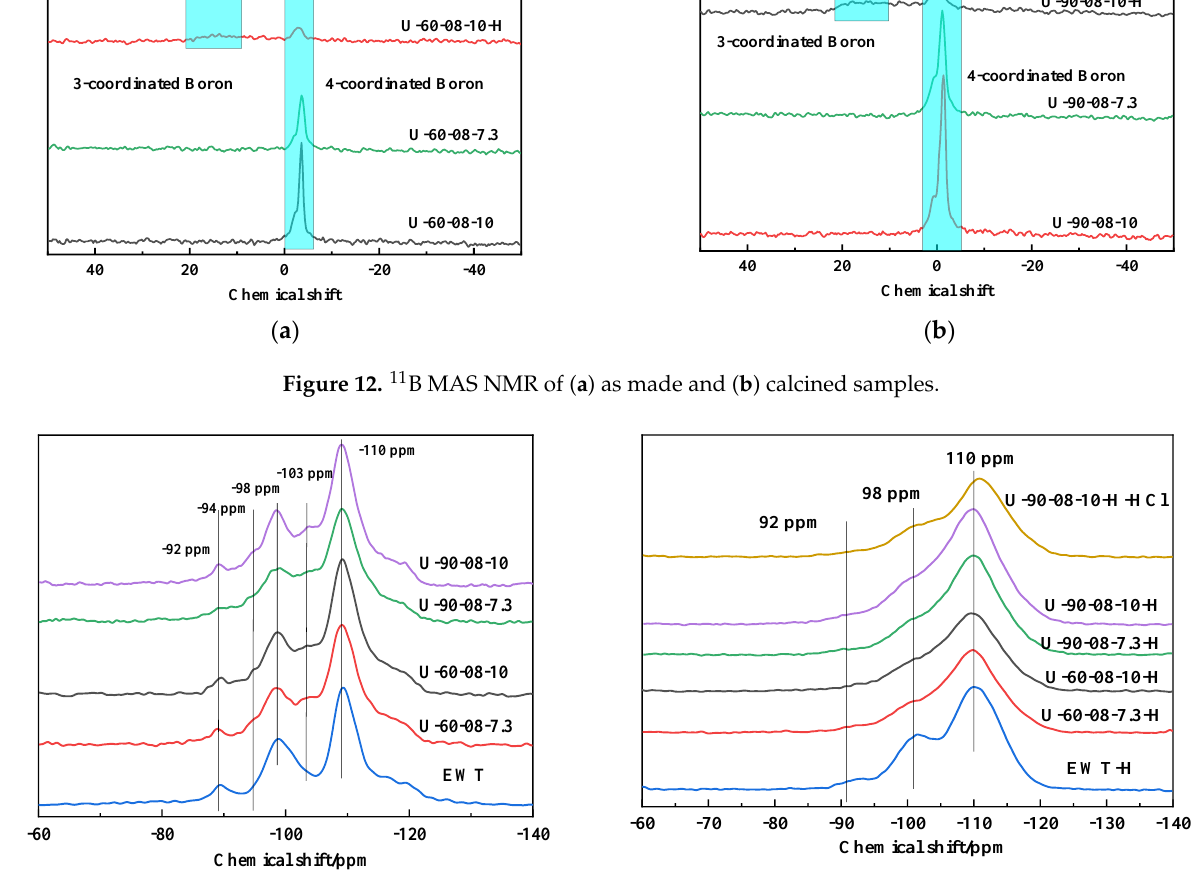
Figure 13. 29 Si MAS NMR of ( a ) as made and ( b ) calcined samples.